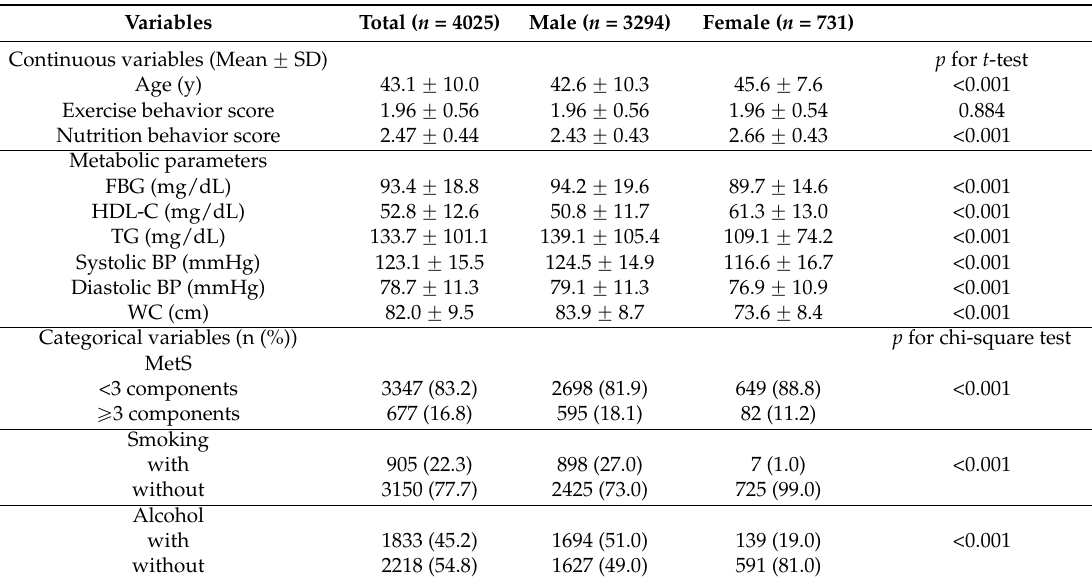
Table 1. Comparing the characteristics of the workers by